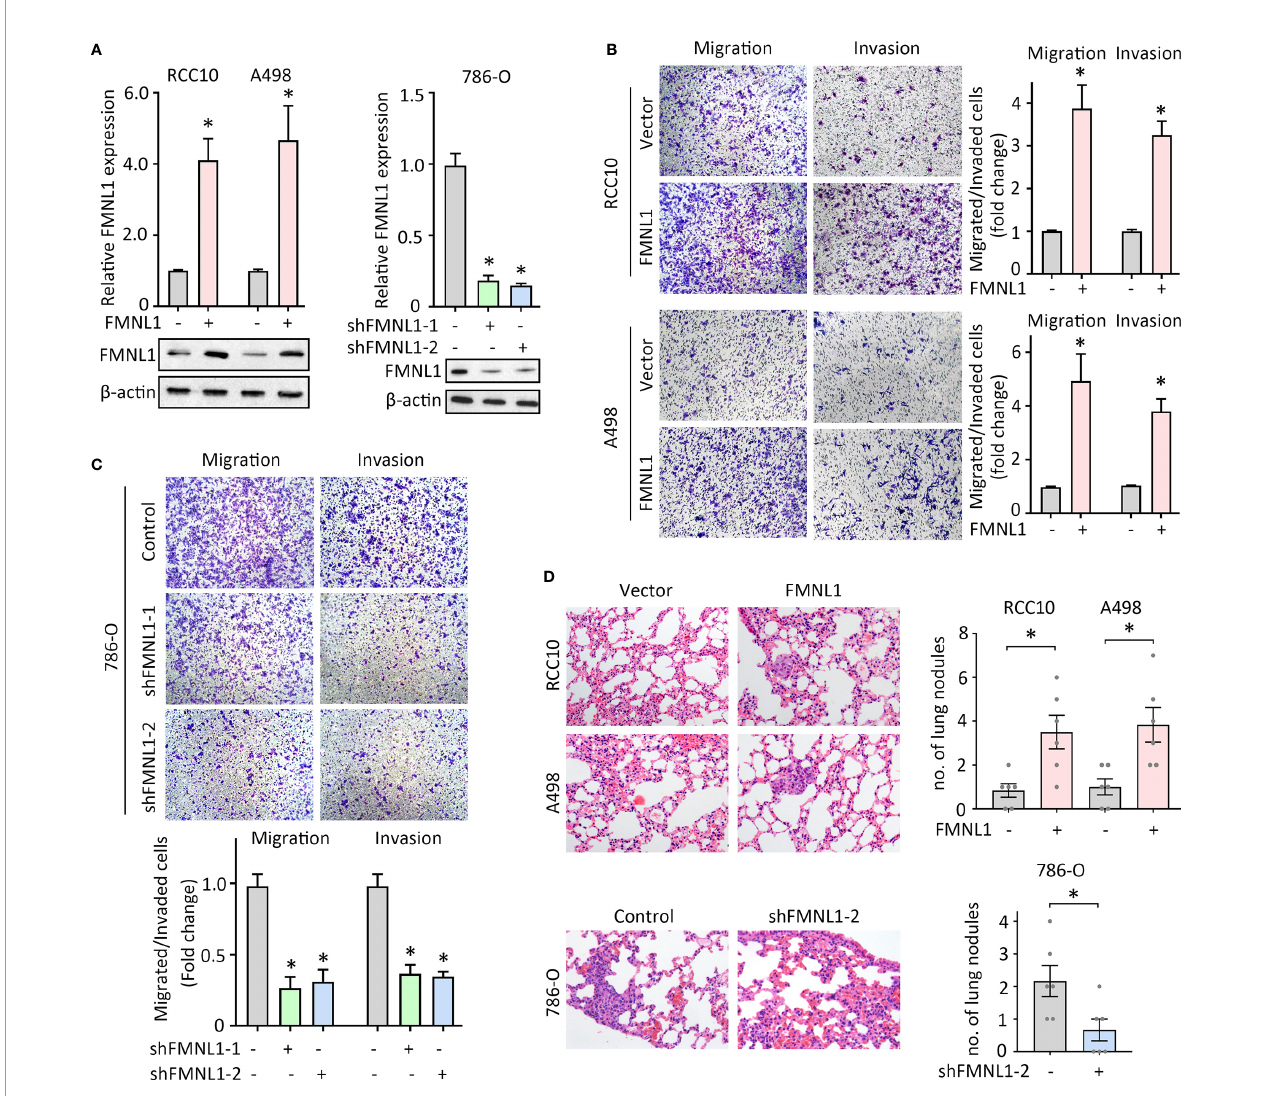
FIGURE 3 | FMNL1 promotes ccRCC cell migration in vitro and tumor metastasis in vivo . (A) RCC10 and A498 cells were transfected with FMNL1 overexpression vector and selected by G418 for 2 weeks. The mRNA and protein expressions of FMNL1 in stable cells were examined by qRT-PCR and western blot. Stable 786-O cells with FMNL1 knockdown was also established. * P < 0.05. (B , C) Stable cells were seeded onto the transwell chamber with or without Matrigel coating and cultured for 36 h. The migrated or invaded cells were stained by 0.05% of crystal violet, and counted under a microscope the indicate the effect of FMNL1 overexpression (B) or silencing (C) on ccRCC cell migration. * P < 0.05. (D) Stable cells were injected into BALB/c nude mice through tail vein. After 40 days, lungs were dissected. HE staining were performed to show the metastatic nodules in the lungs. The number of tumors in lungs was shown by histogram. * P <